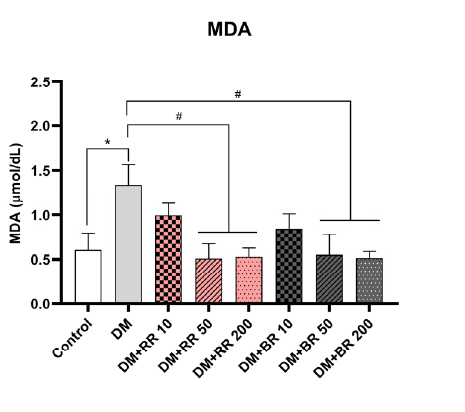
Figure 3. Effects of RR and BR on MDA ( A ) and FRAP ( B ) . Values represent mean ± S . E . M . (n = 8) . * P < 0 . 05, diabetic control group vs . control group; # P < 0 . 05, treated group vs . diabetic control.